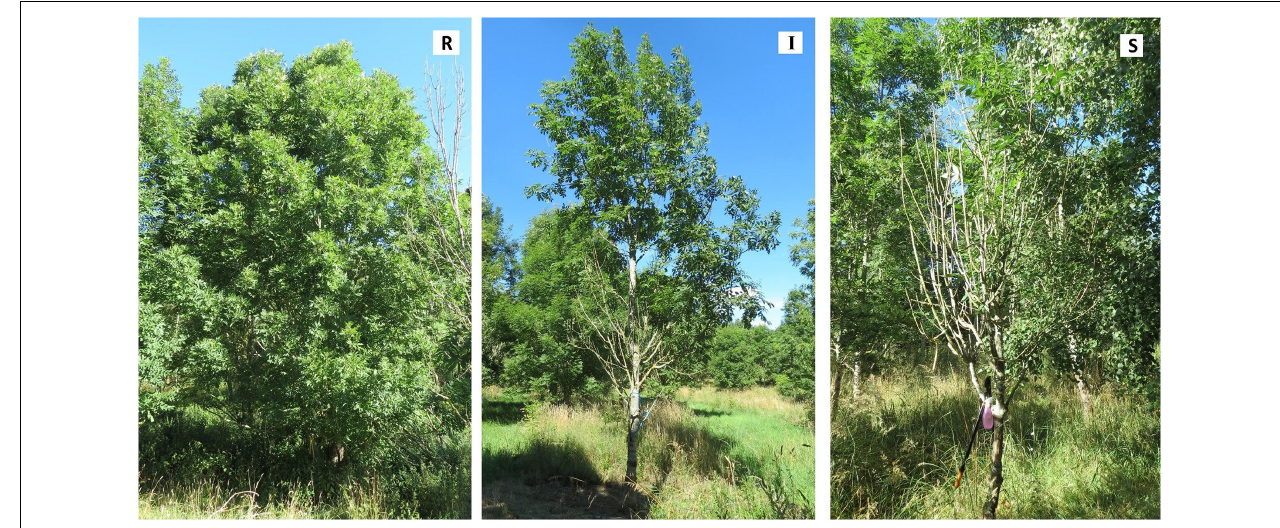
FIGURE 1 | Examples of ash trees representing three susceptibility classes: Resistant (R) , clone 89 at Snogeholm; Intermediate (I) , clone 79 at Trolleholm; and Susceptible (S) , clone 73 at Snogeholm. Photos: Marta